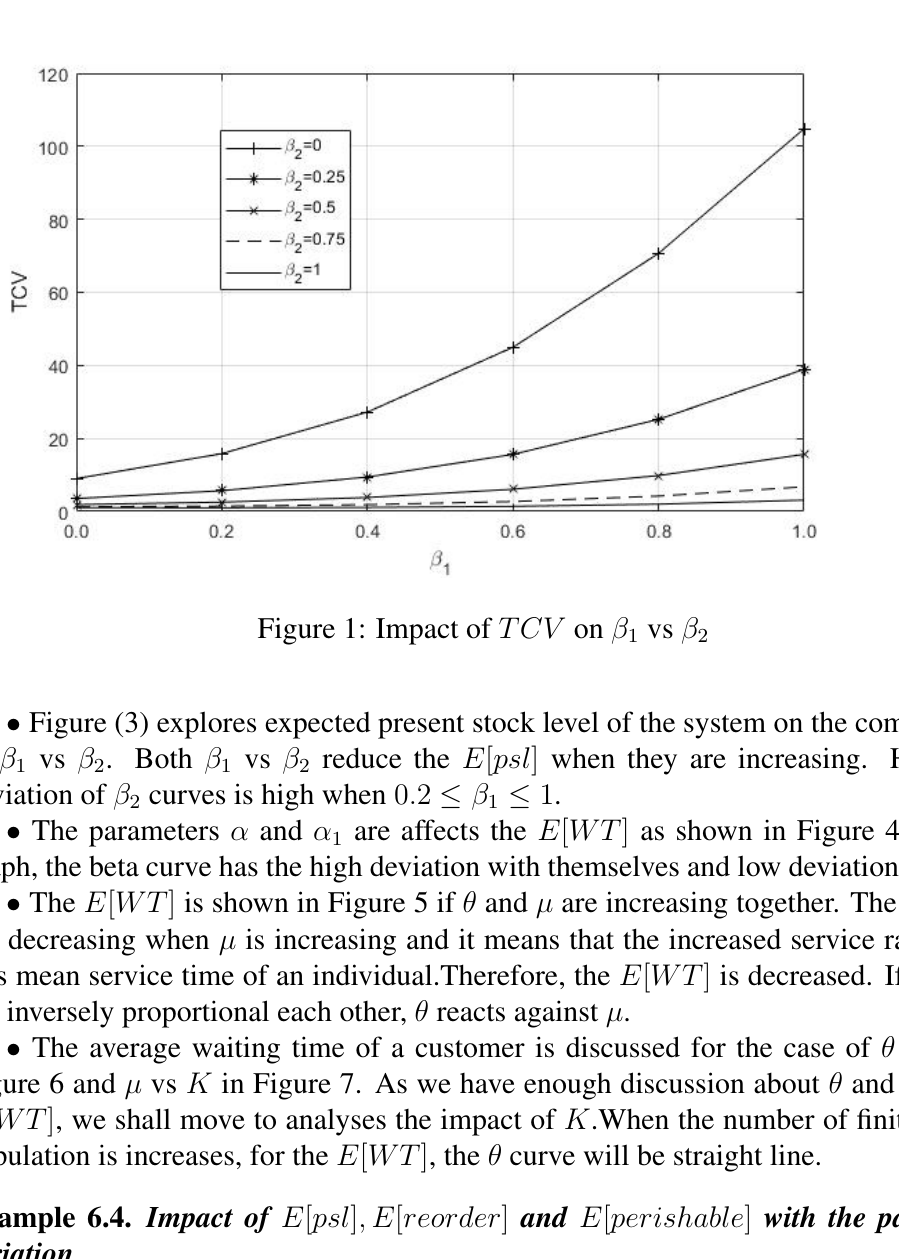
Figure 1: Impact of T CV on β